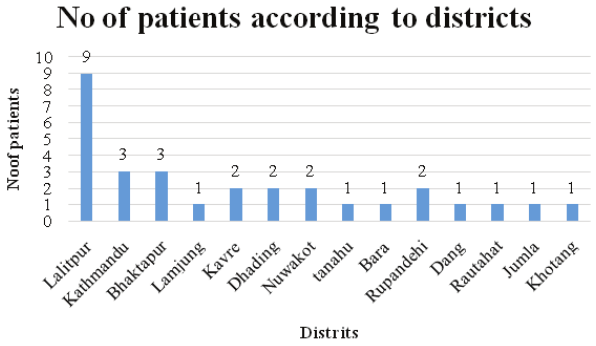
Figure 1: Patients distribution according to districts